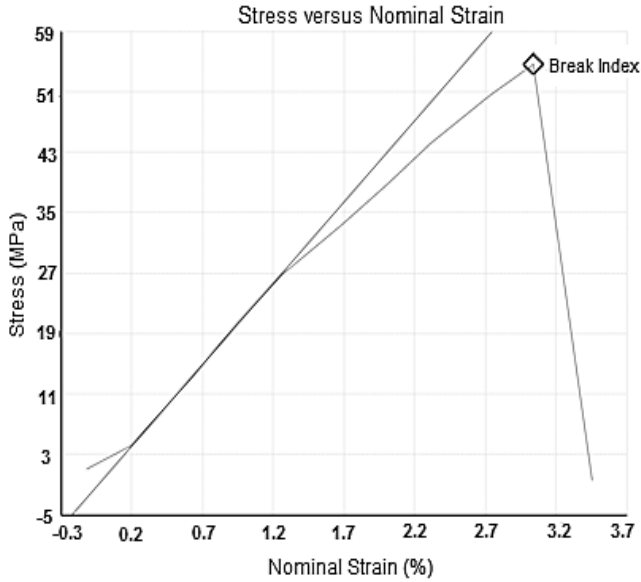
Figure 6. Tensile strength curve of PUM-RSB .